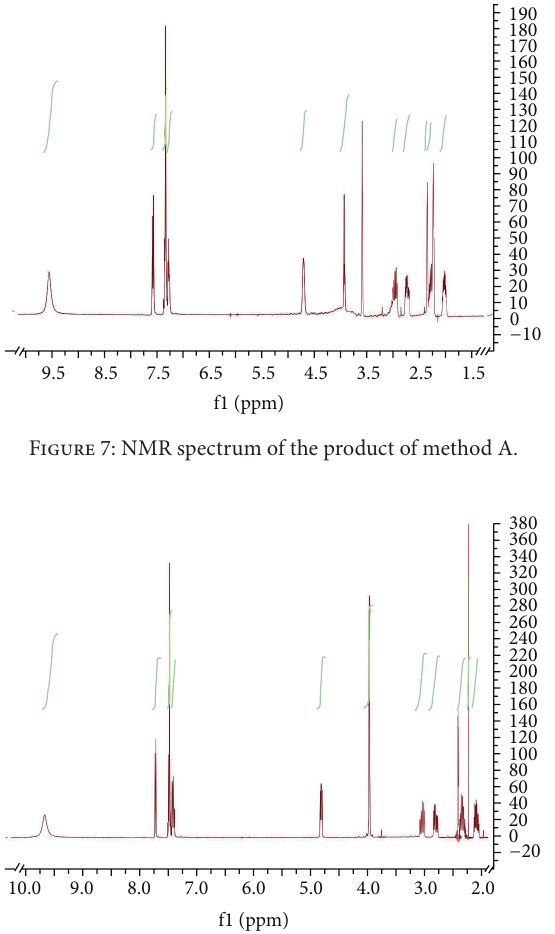
Figure 8: NMR spectrum of the reaction product of method